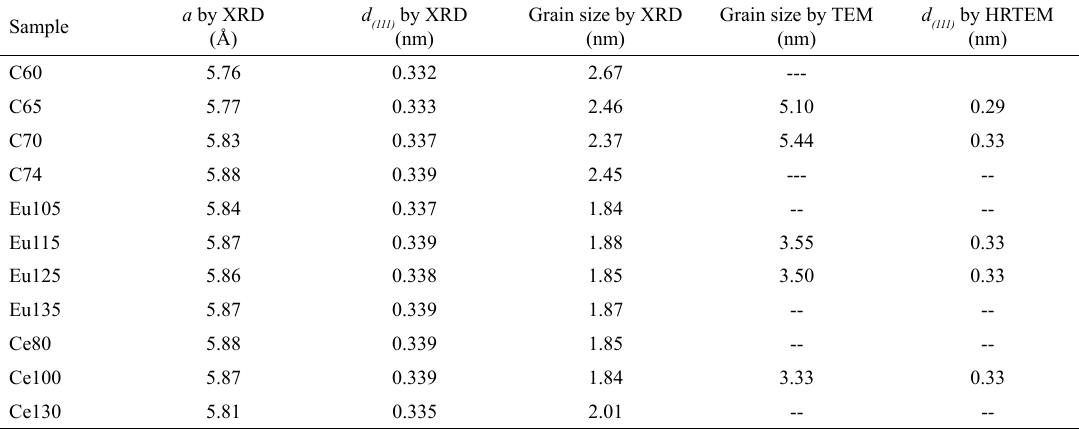
Table 2. Mean grain size of the nanofilms obtained by the Debye-Scherrer equation for the ZB (111) preferred direction showing their dependence on the synthesis time. In addition, it presents the grain sizes obtained by TEM. Additionally, the interplanar distance estimated by X-ray diffraction and by HRTEM are